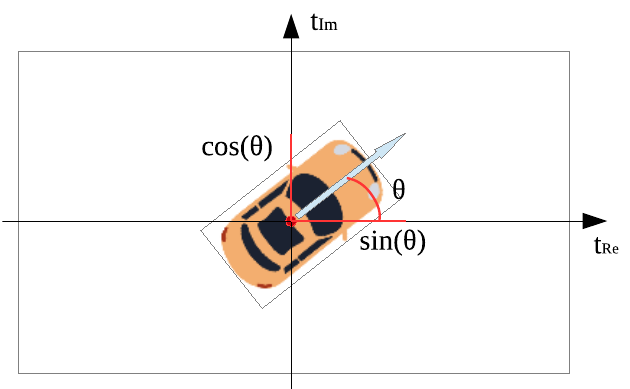
Figure 8. Yaw angle regression in Euclidean space. θ represents the yaw angle of objects, which further is divided into two variables on Im and Re axis. Im and Re represent the imaginary and real components,